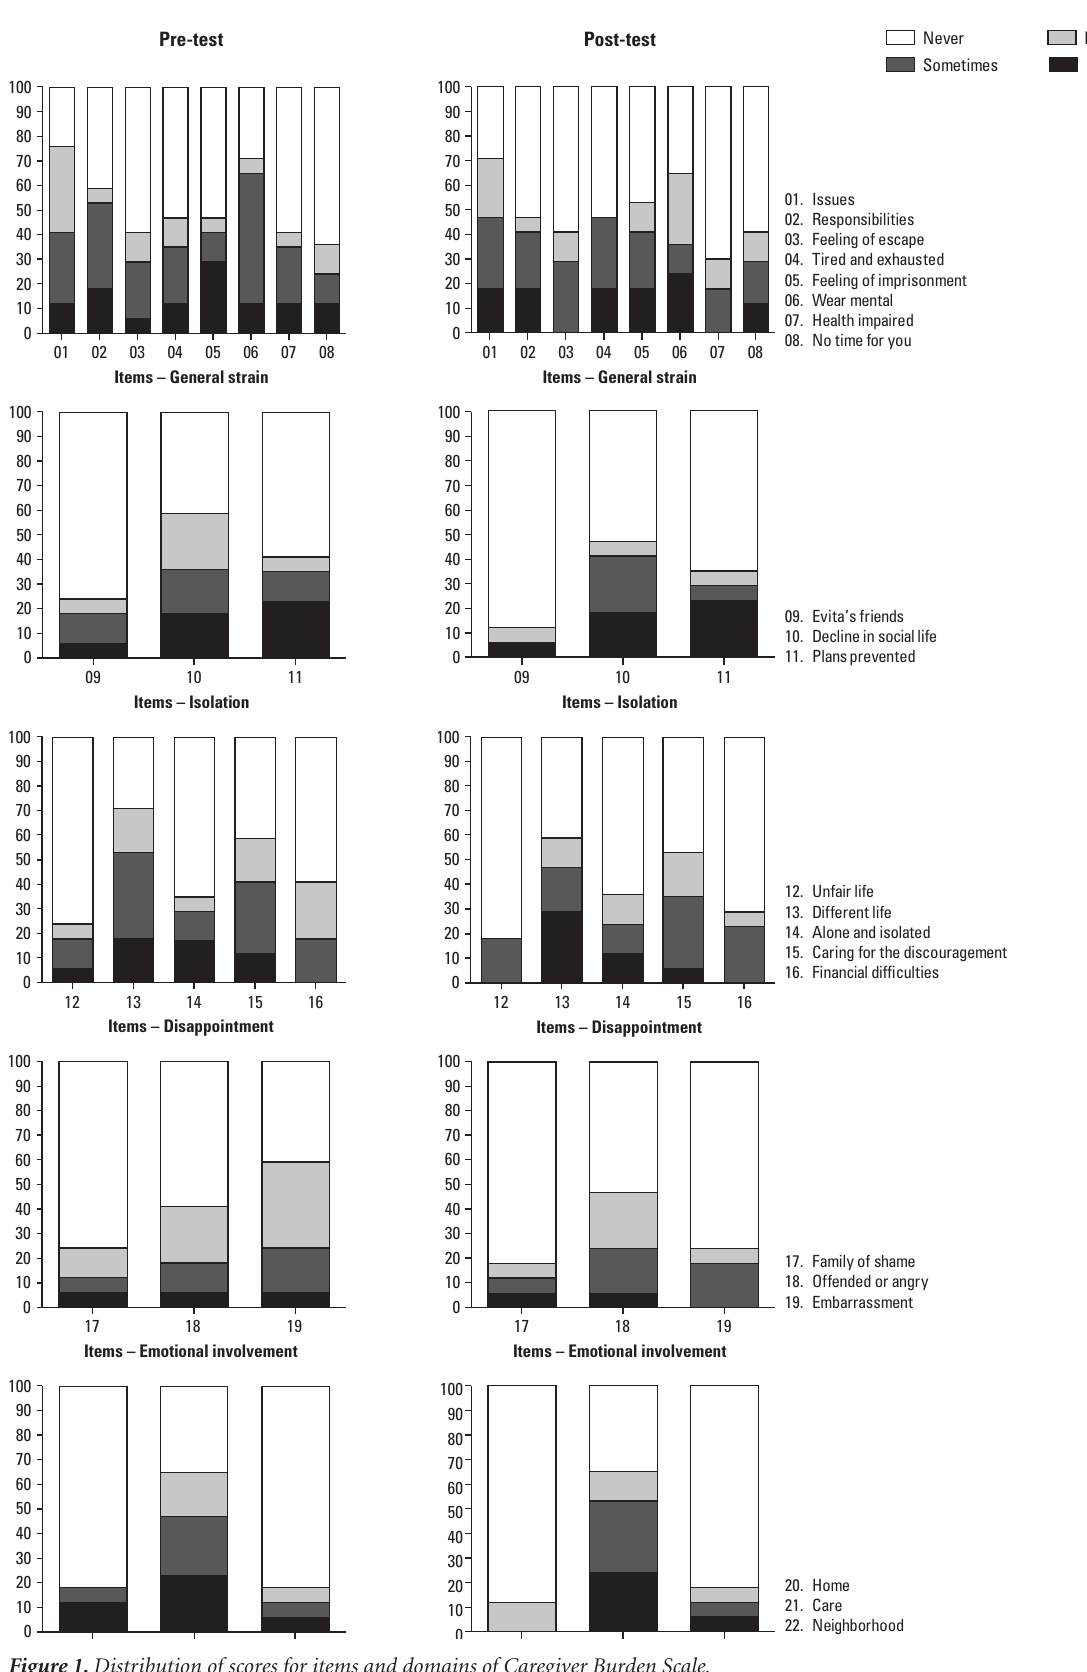
Figure 1. Distribution of scores for items and domains of Caregiver Burden